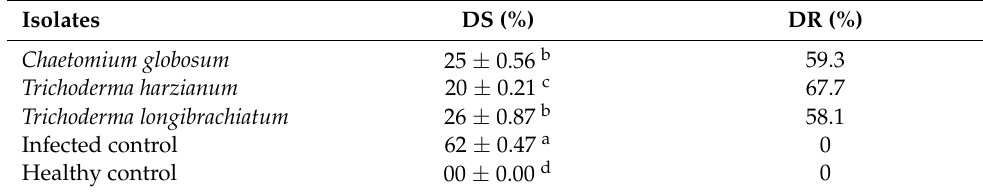
Table 3. Foliar effect of cultural filtrates of bioagents on disease severity (%) after the artificial inoculation of F. solani pathogen under greenhouse